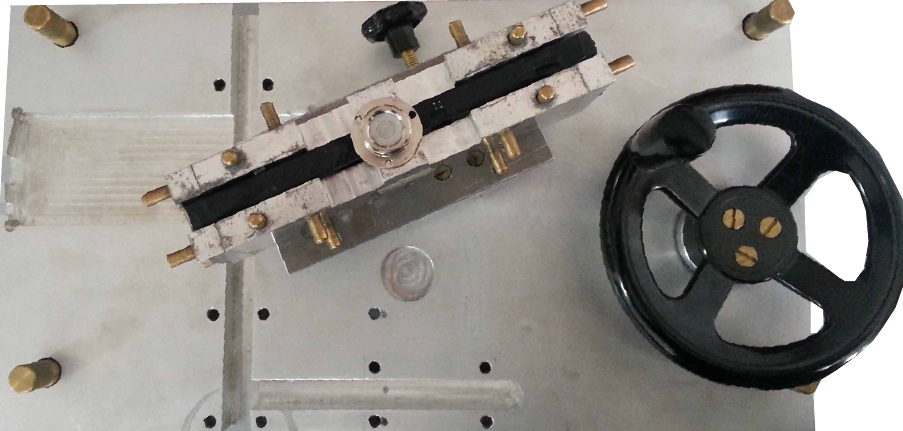
Figure 2. Aluminum platform used in the simplified calibration. By rotating the wheel, 90 degree angle exectutions are performed by the block holding the inertial